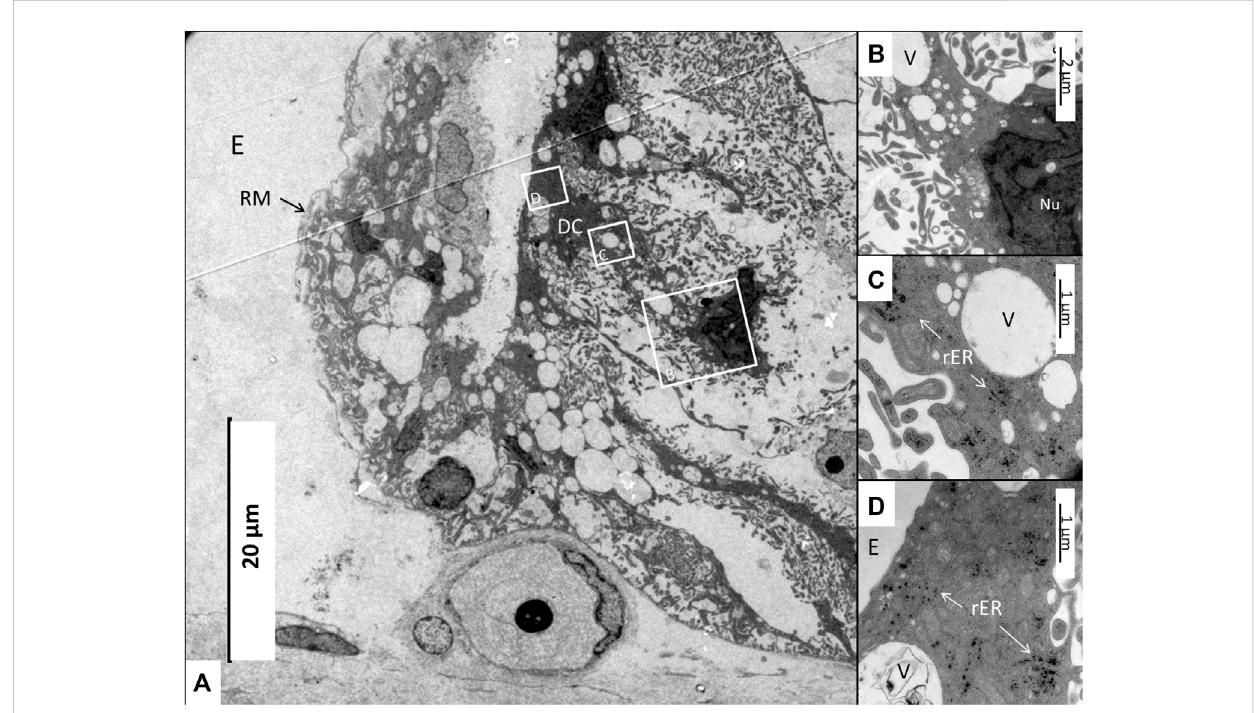
FIGURE 13 (A) Electron microscopy of the stria vascularis near the Reissner membrane (RM) fold. A dark cell (DC, framed) extends basally and its nucleus has translocated. Framed areas are magni fi ed in (B – D) . (B) Higher magni fi cation of framed area in A shows the cell nucleus (Nu) and a large number of secretory-like vesicles (V). (C) Higher magni fi cation of secretory-like vesicles (V) and osmiophilic ribosome aggregates (rER). (D) Apical region with multitudes of mitochondria surrounded by ribosome aggregates. E, Endolymph.